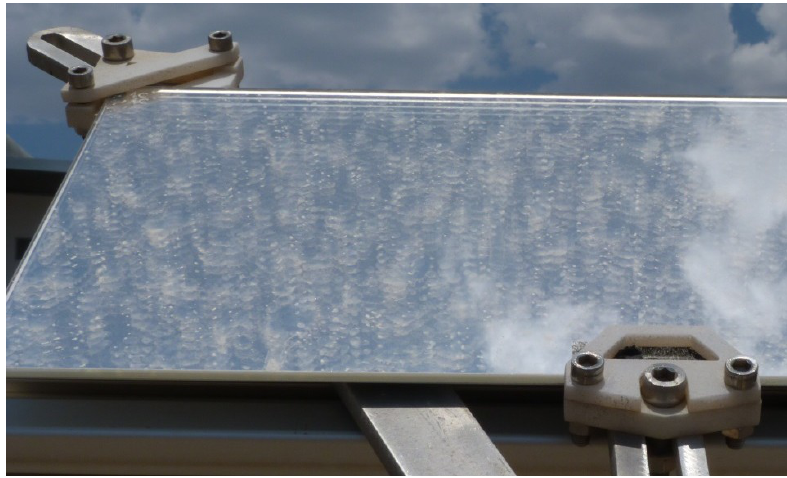
Figure 3. Sample surface after a strong soiling event, showing an inhomogeneous soiling pattern.